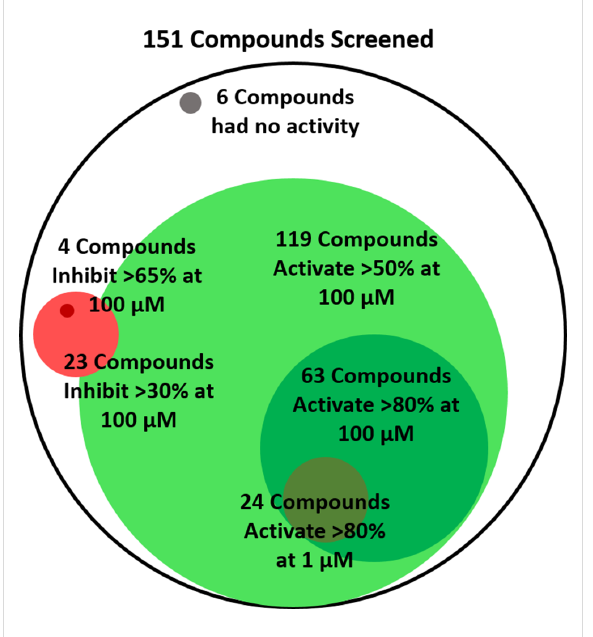
Figure 2: Overview of SdiA agonism and antagonism single-point screening results in the S. Typhimurium reporter. Agonists are indicat- ed in green. Antagonists are indicated in red. Compounds with less than 10% agonism and antagonism (i.e., no activity) are indicated in grey. All circles are scaled to their proportion of the library. Overlaps largely indicative of overlapping compound sets.